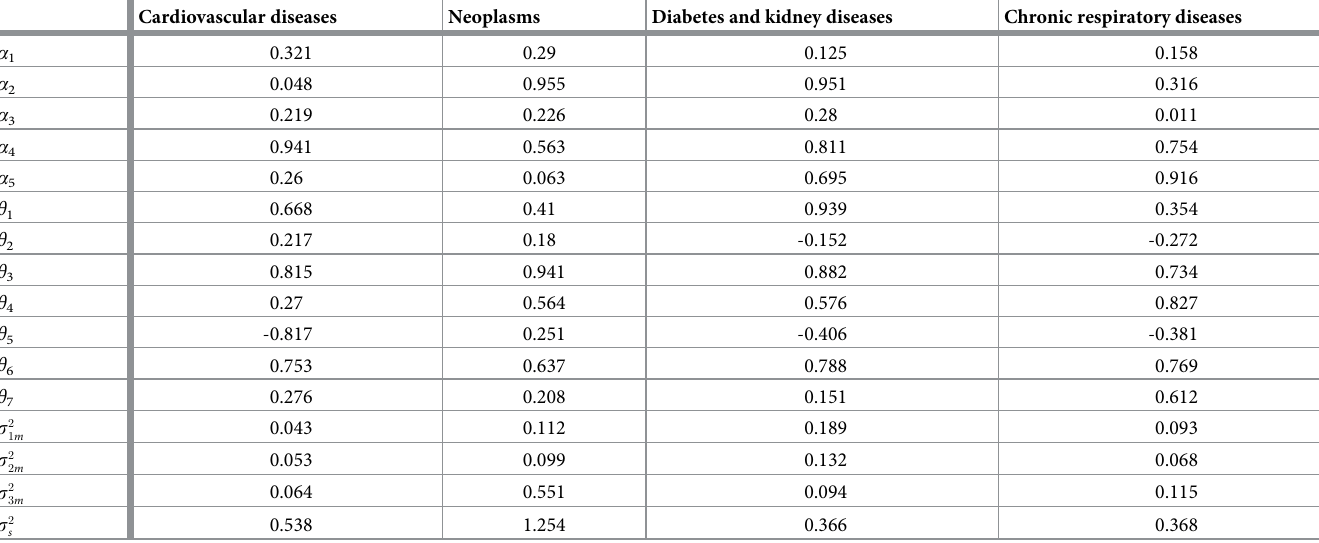
Table 3. Estimated parameters using particle filter. Cardiovascular